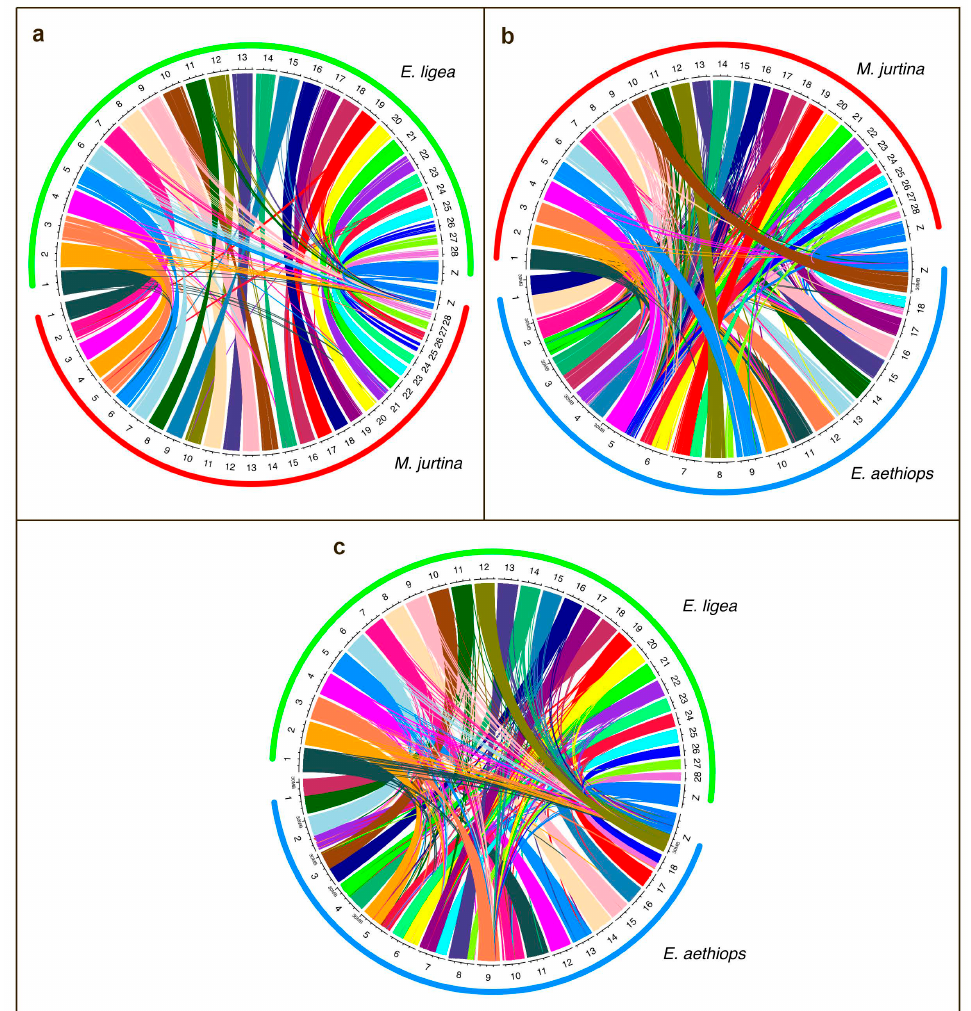
Figure 4. Circos plot showing synteny comparison between E. ligea and E. aehtiops ( a ), E. ligea and M. jurtina ( b ) and E. aethiops and M. jurtina ( c ). Each link corresponds to a single syntenic block (alignment) and is colored by E. ligea ( a , b ) and M. jurtina ( c ) chromosomes. Chromosomes 1–8, 18 and neo-Z of E. aethiops were formed as a result of interchromosomal fusions. Chromosomes of E. ligea and M. jurtina are